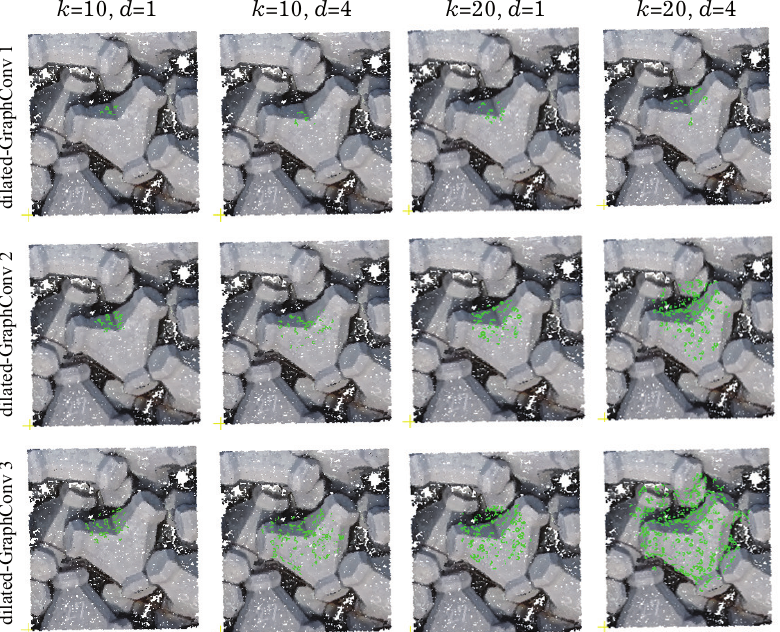
Figure 6. Visualization of the receptive field. The receptive field (green point) expands with deeper networks (rows). Increasing nearest neighbors k and dilation rate d can enhance the receptive field with less computational overhead. When k = 20, d = 4, the receptive field of the third layer can roughly cover a complete